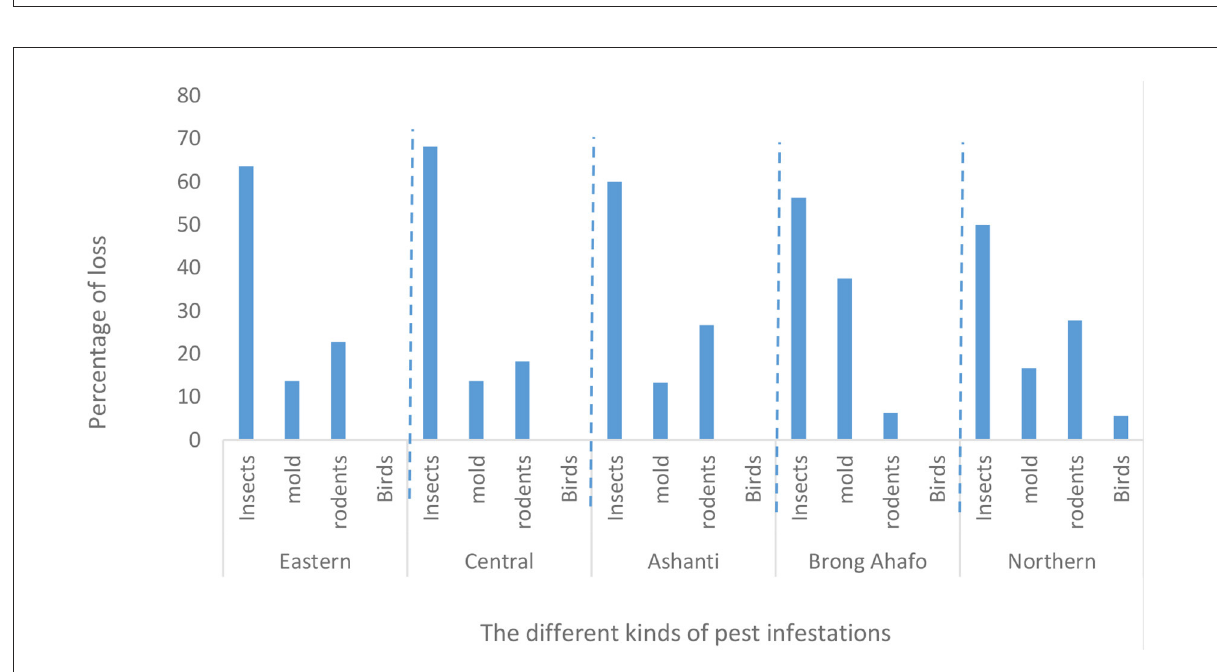
FIGURE9 Loss (%) in maize grain due to different kinds of pest infestations in